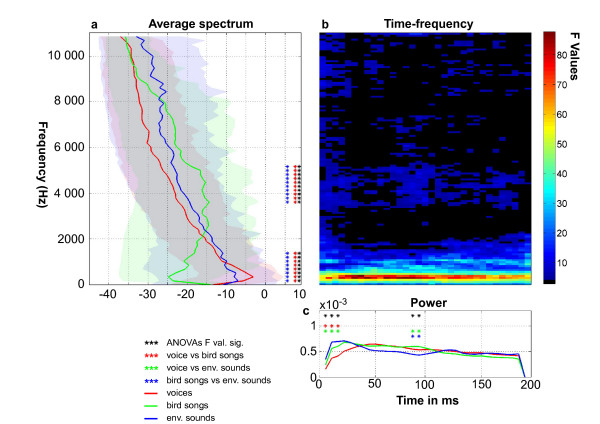
Acoustical differences between sound categories. a) Red, blue and green lines show the average power spectrum of their respective sound categories (see legend). Stars highlight frequency bands showing a significant effect of sound category. 95% confidence intervals are indicated by shaded areas. b) Time-frequency analysis. The significance of the sound categorical difference effect is indicated by the colormap. Black areas indicate non-significant results. Frequency axis as in figure 1a. c) Power Analysis in time. Red, blue and green lines show the average power of the respective sound categories over the 200 ms duration. Black stars indicate time points showing a significant effect of sound category; blue and green stars indicate significant post-hoc tests. Note that the largest effect of sound category is a higher power in the low frequencies for voices and environmental sounds compared to bird songs.